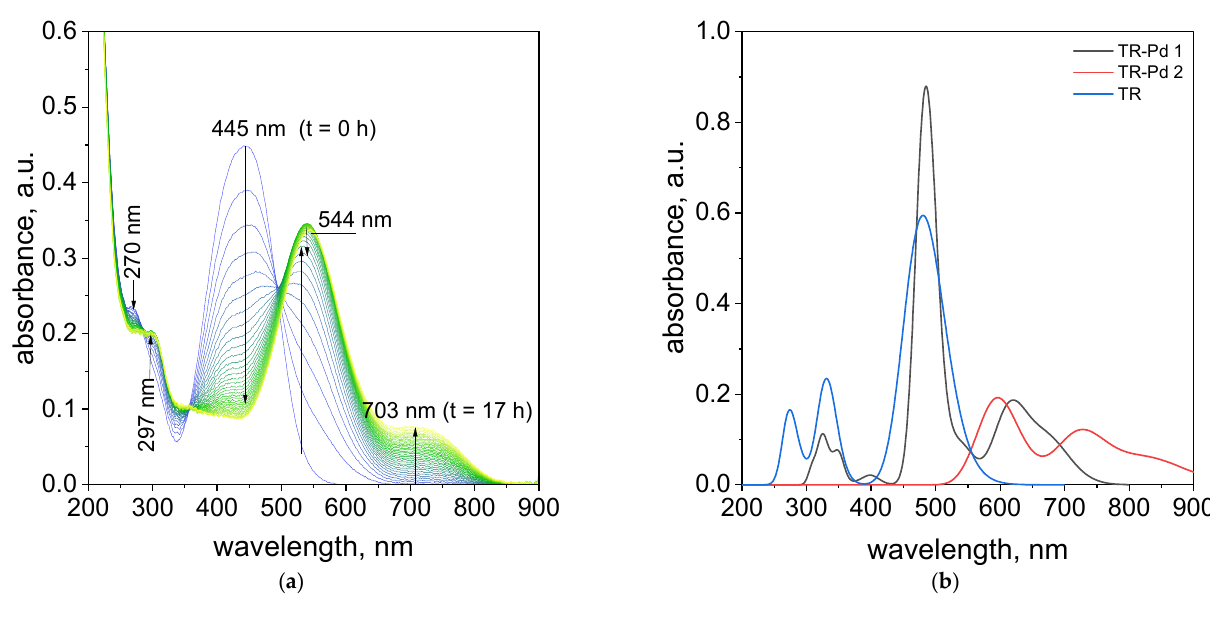
Figure 3. The UV–Vis spectra evolution (24 h) of the solution containing the mixture of tropaeolin OO and Pd(II) at 20 °C. Conditions: volumetric ratio: 2.5 mL Pd(II):1.5 mL TR the value of concentration of Pd(II) ions after mixing with tropaeolin OO: TR = 1.875 × 10 − 5 mol/dm 3 , Pd(II) = 3.125 × 10 − 5 mol/dm 3 , pH = 4.10 ( a ), calculated spectra ( b ).